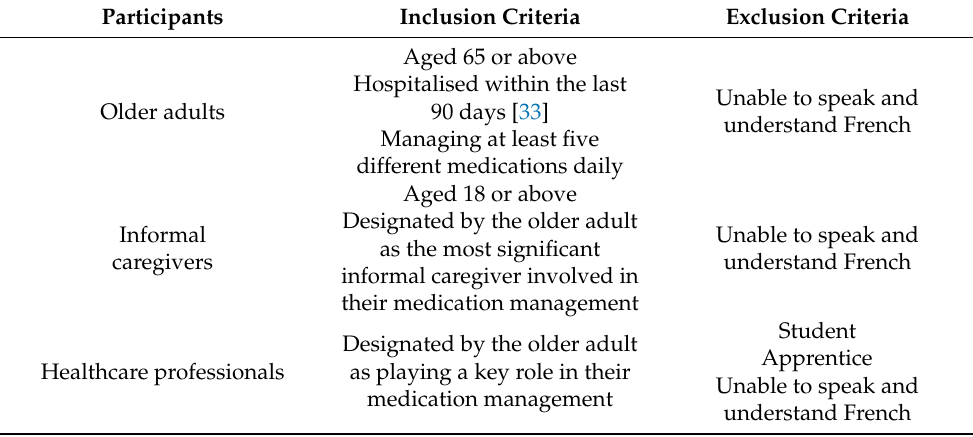
Table 1. Inclusion and exclusion criteria for different groups of